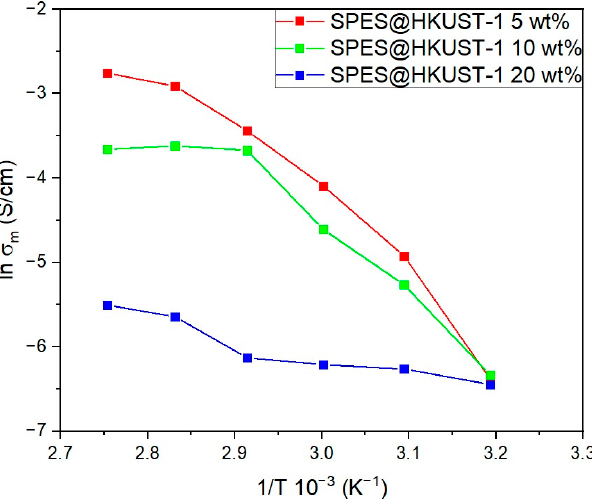
Figure 2. Ex situ proton conductivity of the SPES@HKUST-1 membranes with MOF HKUST-1 loading of 5, 10, and 20 wt. %, as a function of temperature at 90% RH.